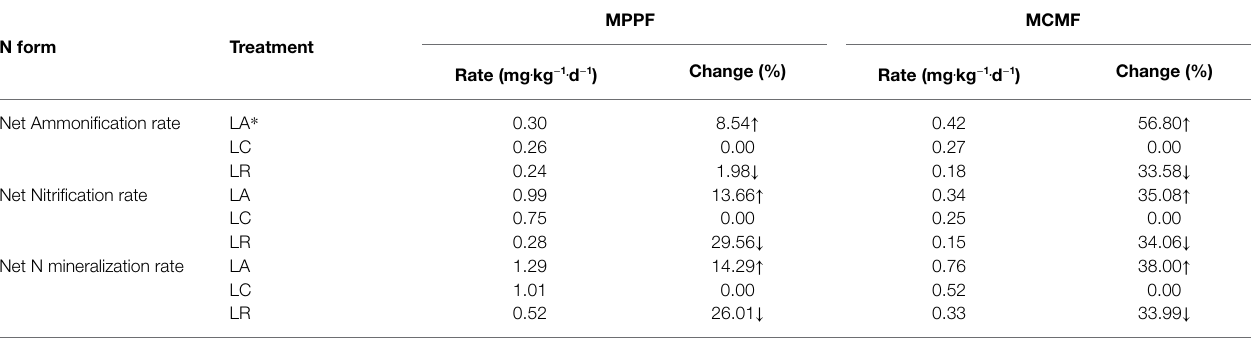
* LA, litter addition; LC, litter control; LR, litter removal; MPPF, Masson pine pure forests; MCMF, Masson pine and Camphor tree mixed forests. Upper ↑ indicates a positive change, and down ↓ indicates a negative change in LA and LR treatments compared to LC treatment.